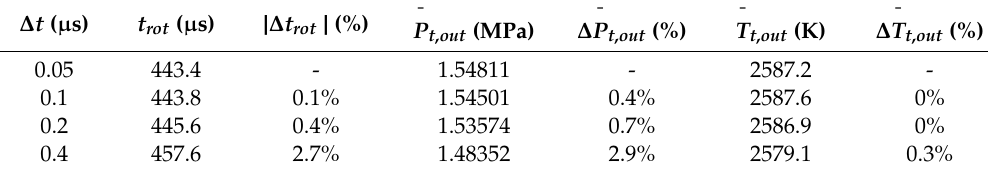
Table 2. Time step independence verification (grid size of 1.2 mm).